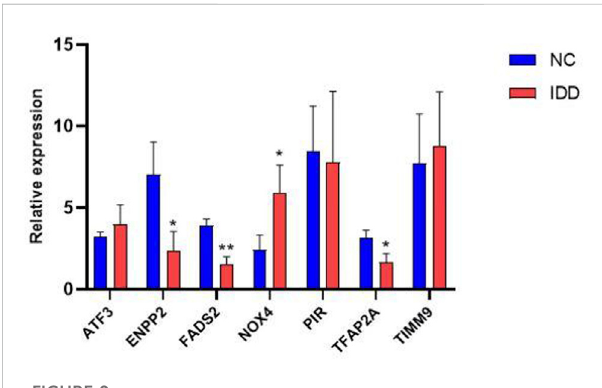
FIGURE 9 ThemRNArelativeexpressionlevelsofNOX4,ENPP2,FADS2and TFAP2A in the IDD ( n = 5) and normal groups ( n = 5) were veri fi ed by RT-PCR operated, and the expression was calculated using the 2 − ΔΔ CT method. The expression of NOX4, ENPP2, FADS2 and TFAP2A warestatisticallysigni fi cant(*, p < 0.05;**, p < 0.01),wharesthereware no difference in ATF3, PIR and TIMM9